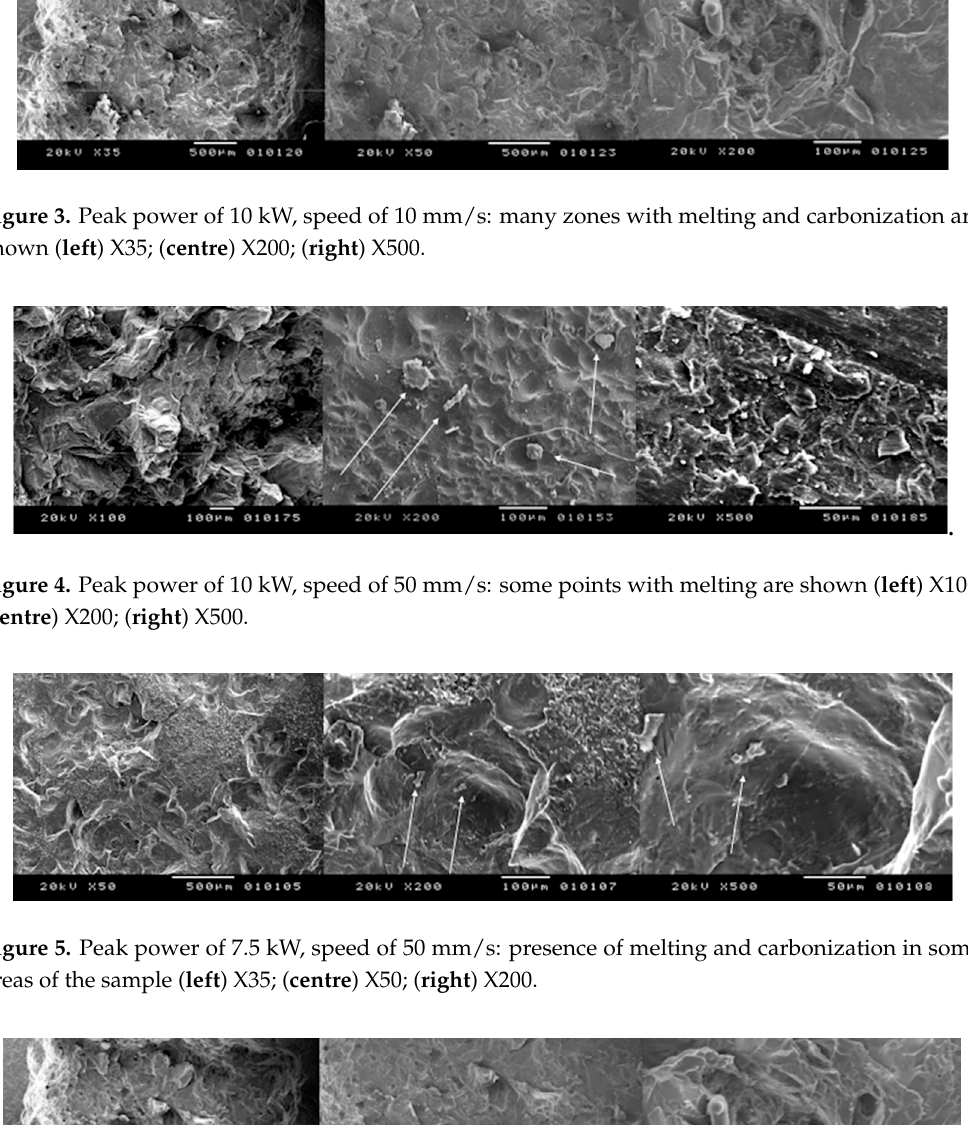
Figure 6. Peak power of 5 kW, speed of 10 mm/s: evidence of some zones with melting ( left ) X50; ( centre ) X100; ( right ) X500.